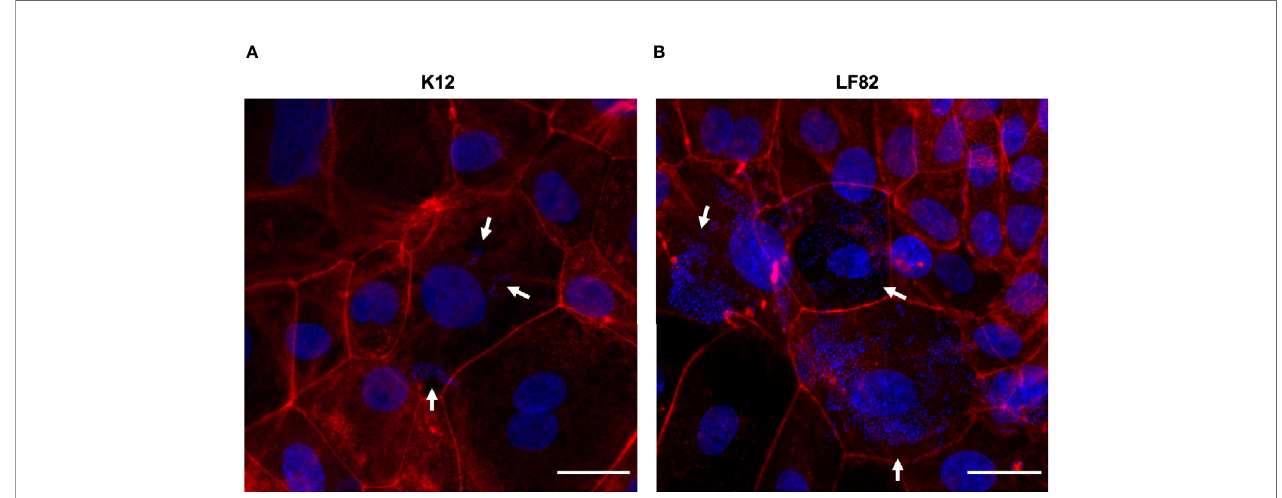
FIGURE 4 | E. coli LF82 and K12 invasion of d-ODMs as determined by the gentamicin protection assay. Phalloidin staining was performed to visualize the non- invasive control strain K12 (A) and the invasive LF82 (B) in d-ODMs after 5 hours of infection and 1 hour of gentamicin treatment at MOI 100. Phalloidin marked the eukaryotic actin fi laments while DAPI bound to the DNA of both epithelial and bacterial cells. White arrows show bacterial localization inside the IECs. Scale bars: 25µm. Images are representative of n = 3 independent experiments performed with samples from two different